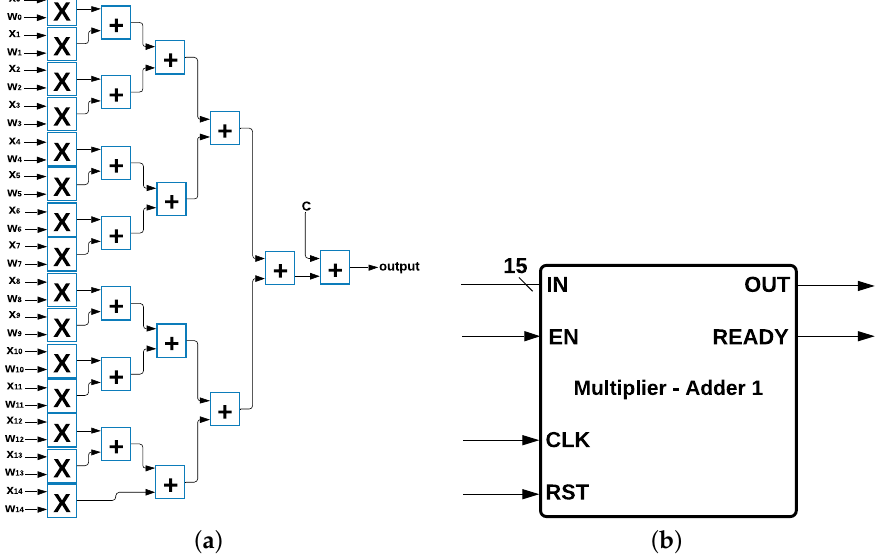
Figure 4. Multiplier Adder Module 1 and its Components. ( a ) Common Multipliers and Adders. ( b ) Multiplier Adder Module